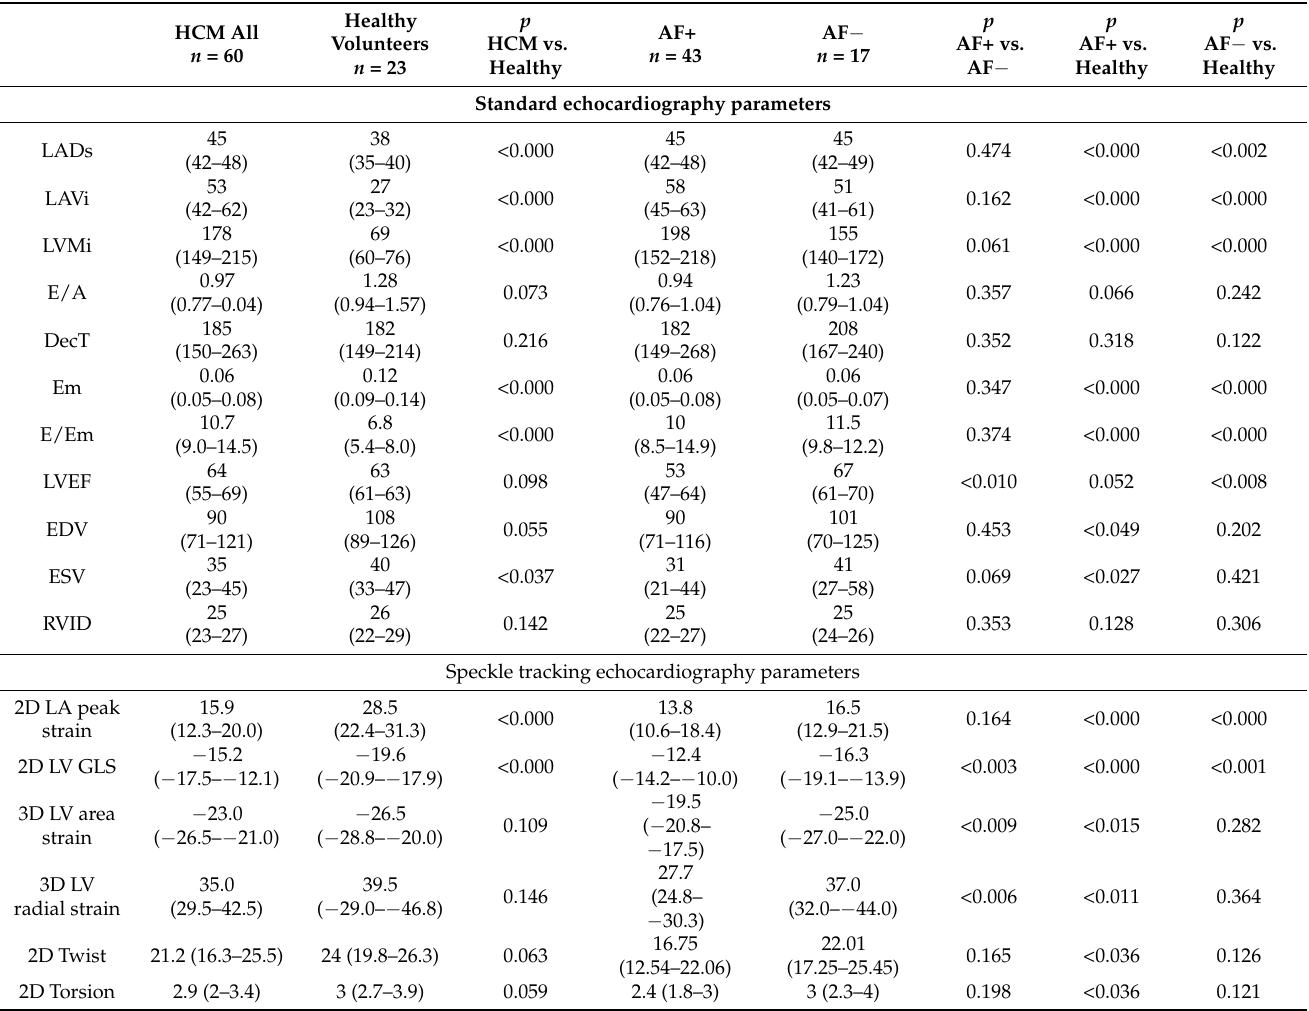
Table 2. Echocardiographic parameters.